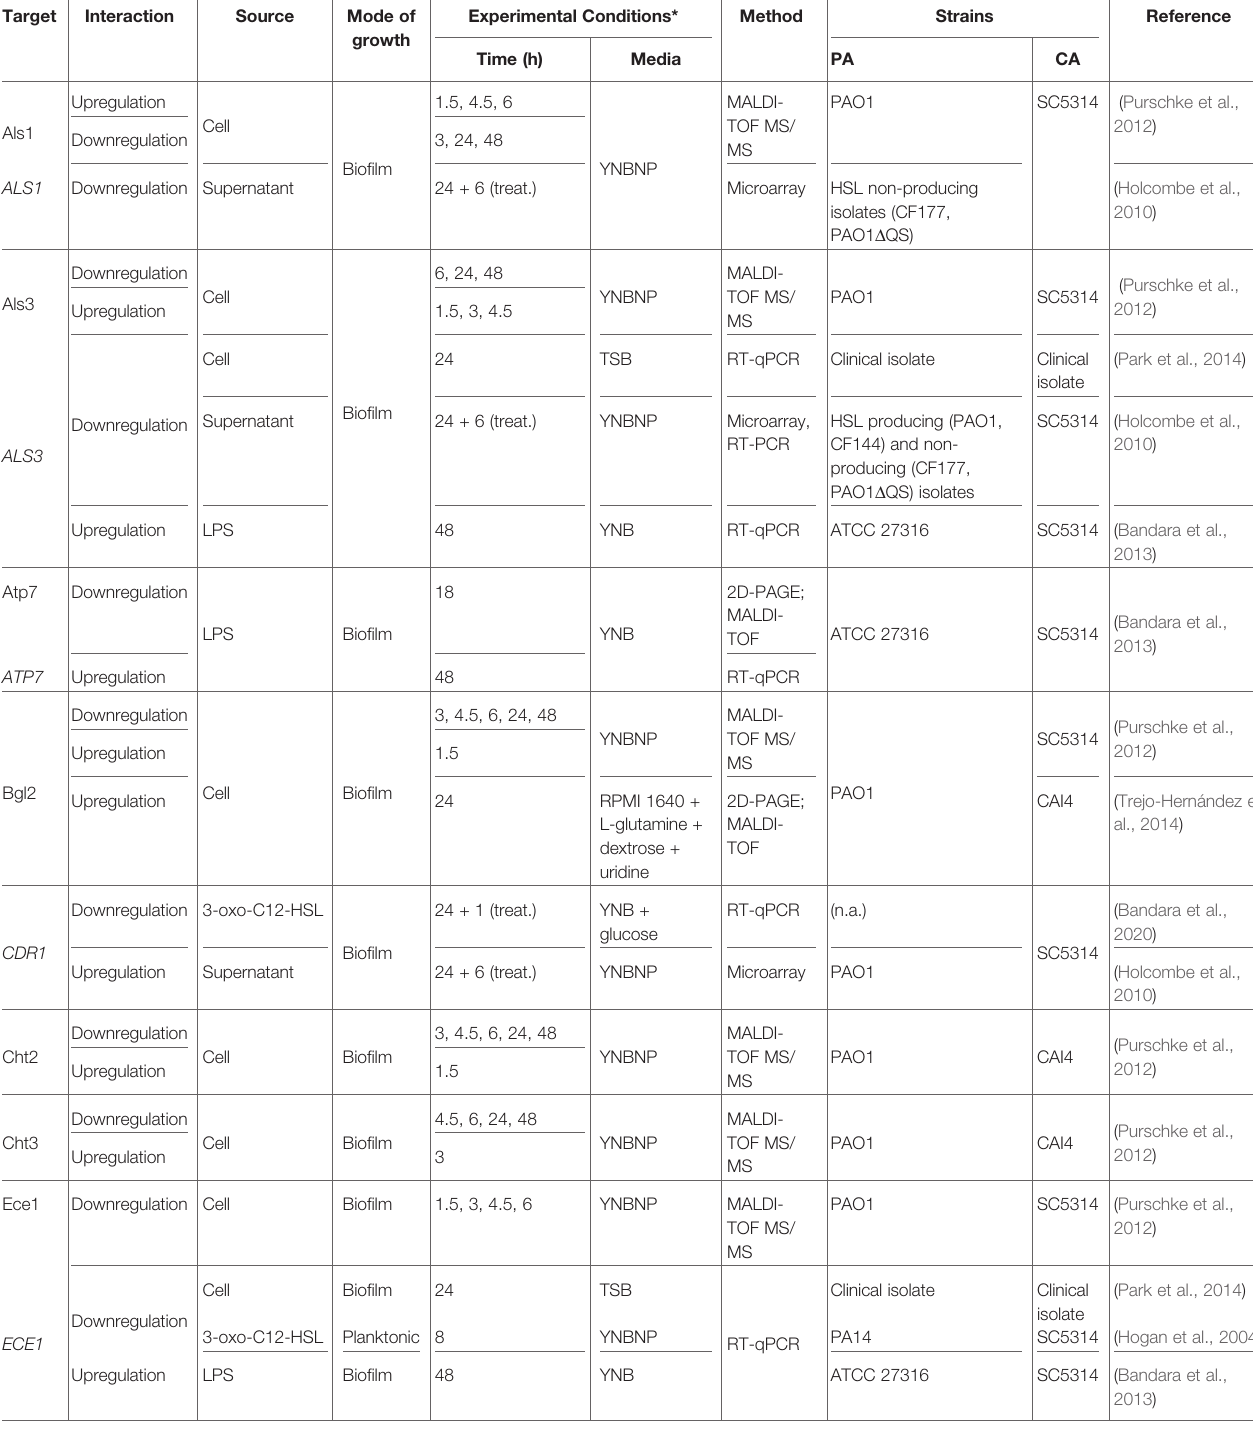
TABLE 2 | Contrasting P. aeruginosa > C. albicans